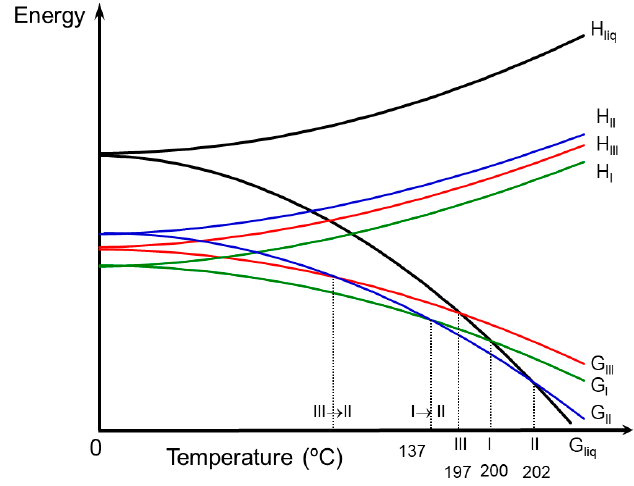
Figure 4. Semi-schematic energy/temperature diagram of anhydrous forms of BL.